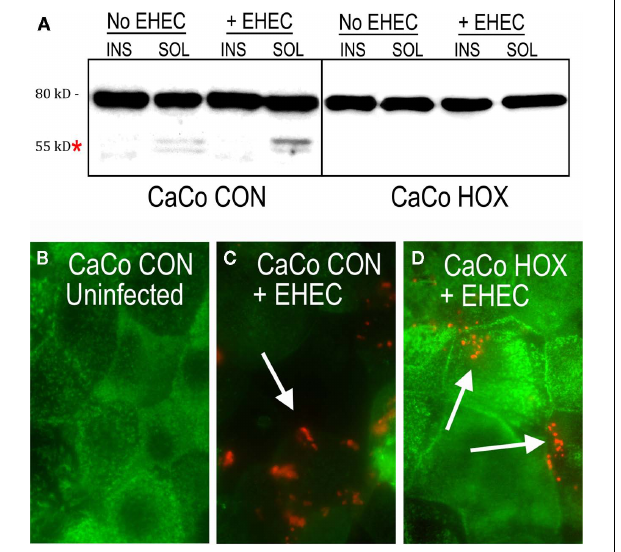
FIGURE 5 | Enterohemorrhagic Escherichia coli infection caused calpain-dependent loss of mirovillar ezrin and ezrin cleavage. Lysates from subcellular fractions of polarized control CaCo-2a CON and HOX monolayers with and without 6h EHEC infection by were probed for ezrin by western blot. Asterisk (or arrow) indicates the ∼ 55kDa ezrin cleavage product (A) . Polarized CaCo-2a CON cells without (B) and with 6h infection by EHEC (C) and EHEC-infected polarized HOX monolayers (D) were stained for ezrin (green) and EHEC (red). EHEC was detected by anti-O157